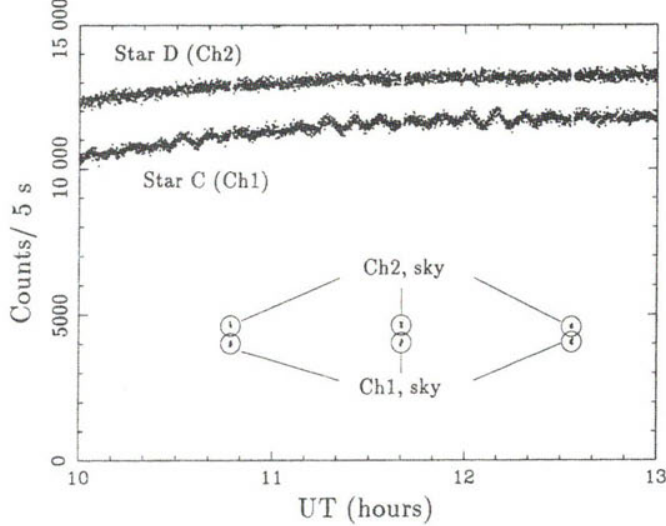
Fig. 2. Three hours of raw high-speed photometry on two stars ob- tained at MJUO during the XC0V9 campaign in 1993. Star C is the pulsating pre-white dwarf PG 1159-035 and star D is a nearby constant comparison star. The circled points correspond to sky counts. The data displayed in Fig. 2 is from XCOV9. Even